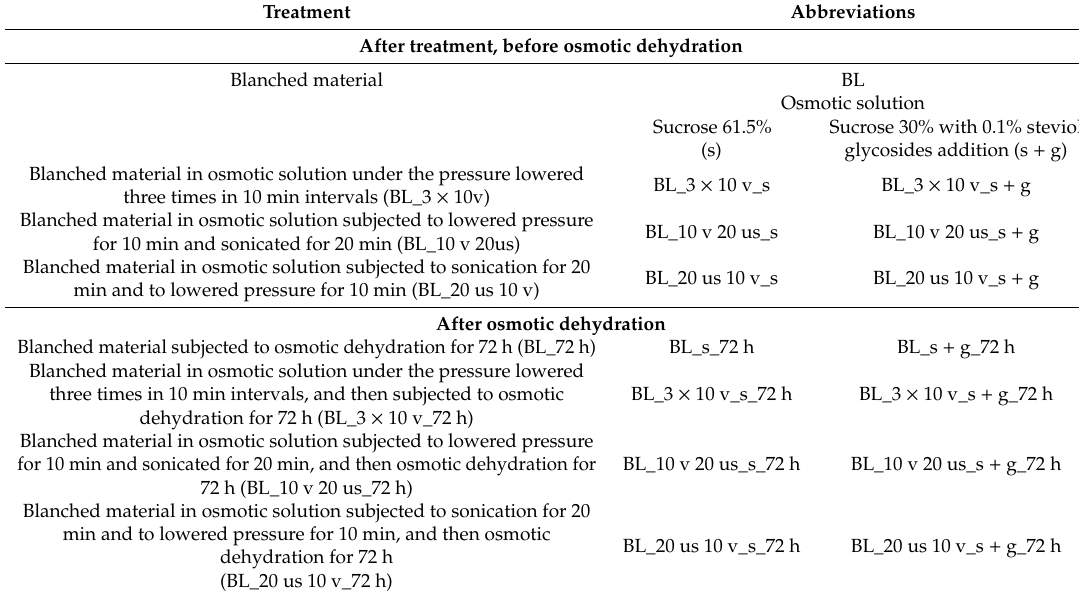
Table 1. Abbreviations of all researched samples of